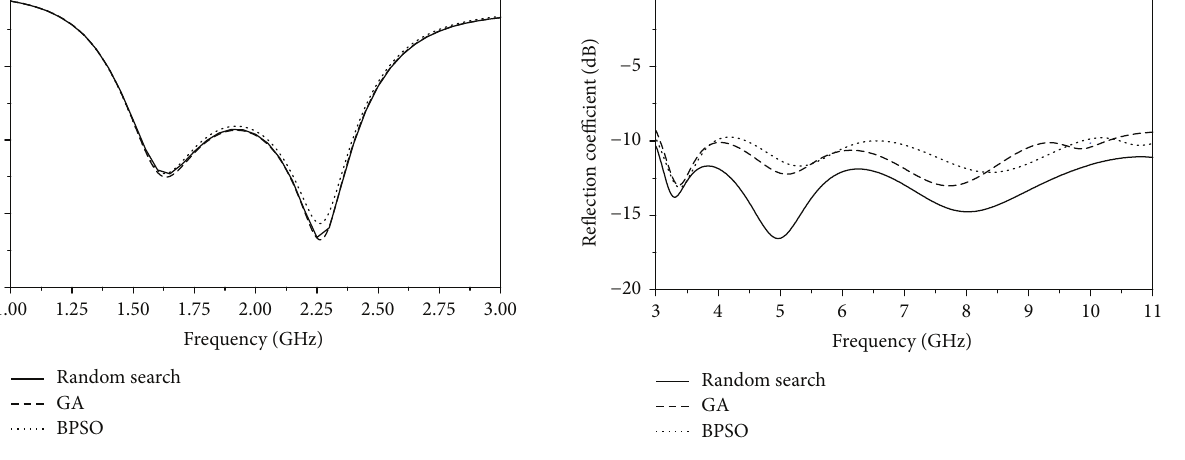
Figure 7: Simulated reflection coefficients of the optimized UWB monopole antennas corresponding to the GA, the BPSO, and the random search